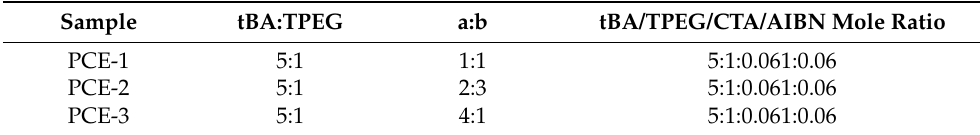
Table 3. Monomer composition for the A a BA b -type PCEs synthesized in this work.